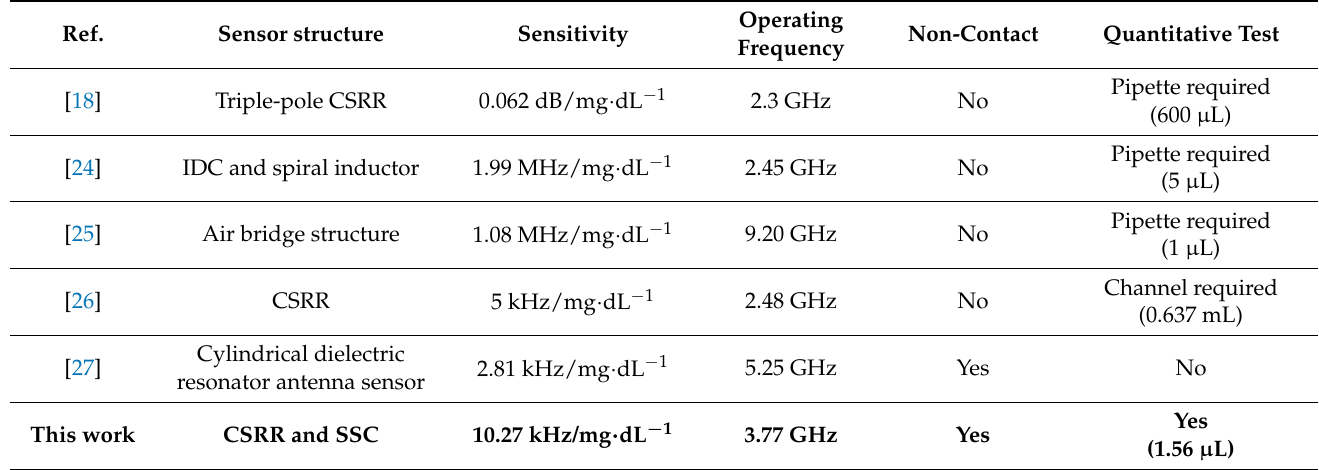
Table 1. Performance comparison with other previously reported